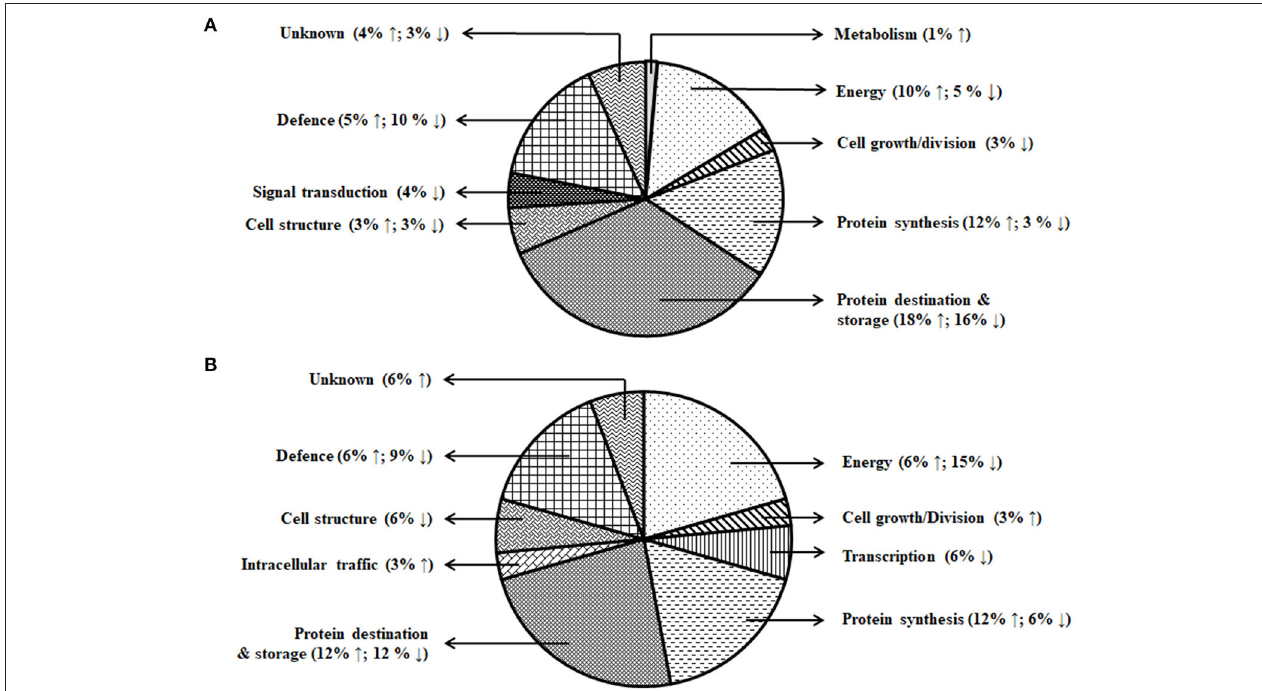
FIGURE 5 | Functional classification of the differentially expressed proteins. (A) Day stress and (B) day–night stress. Proteins are classified according to Bevan et al. (1998).